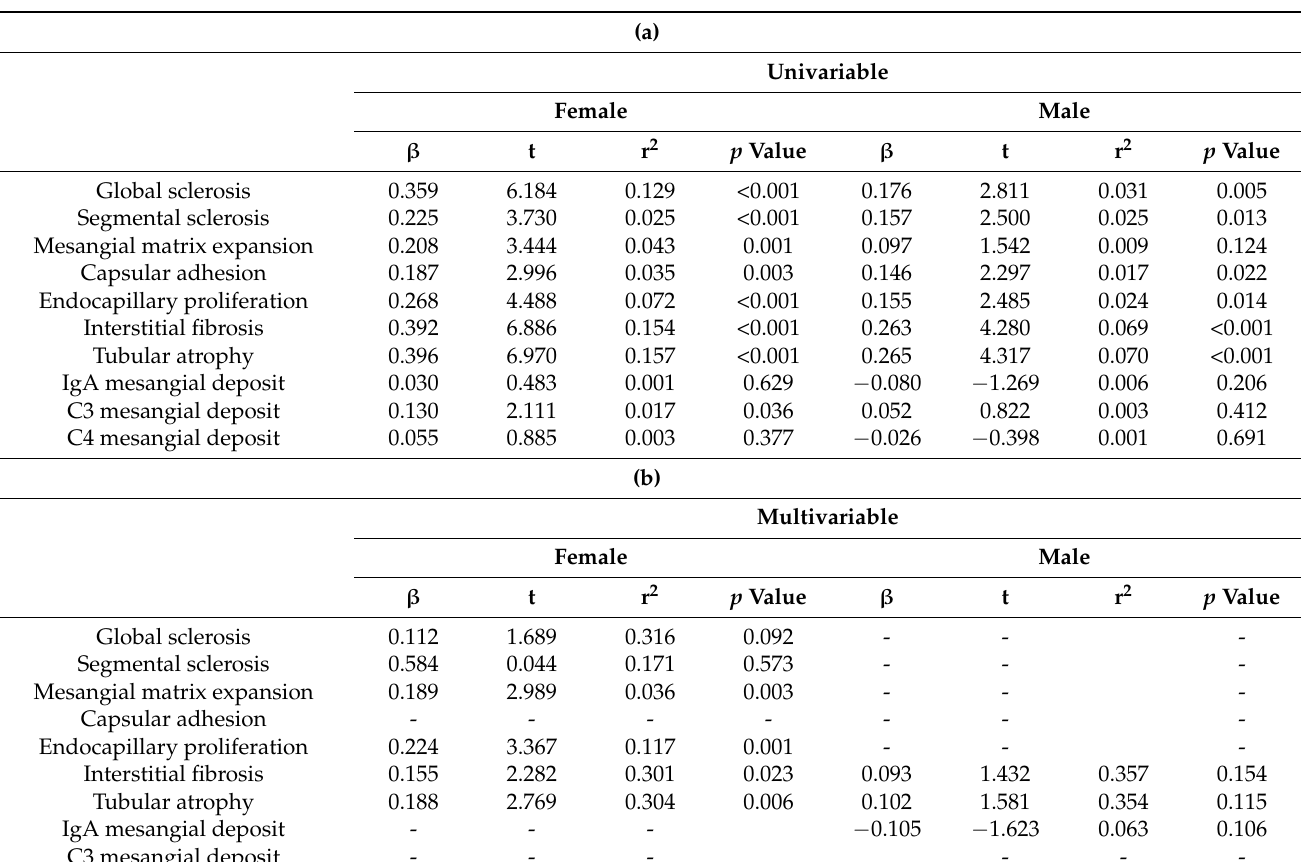
Table 5. Linear regression for uric acid and the histopathologic parameters in sex differences (a) univariable analysis (b) multivariable